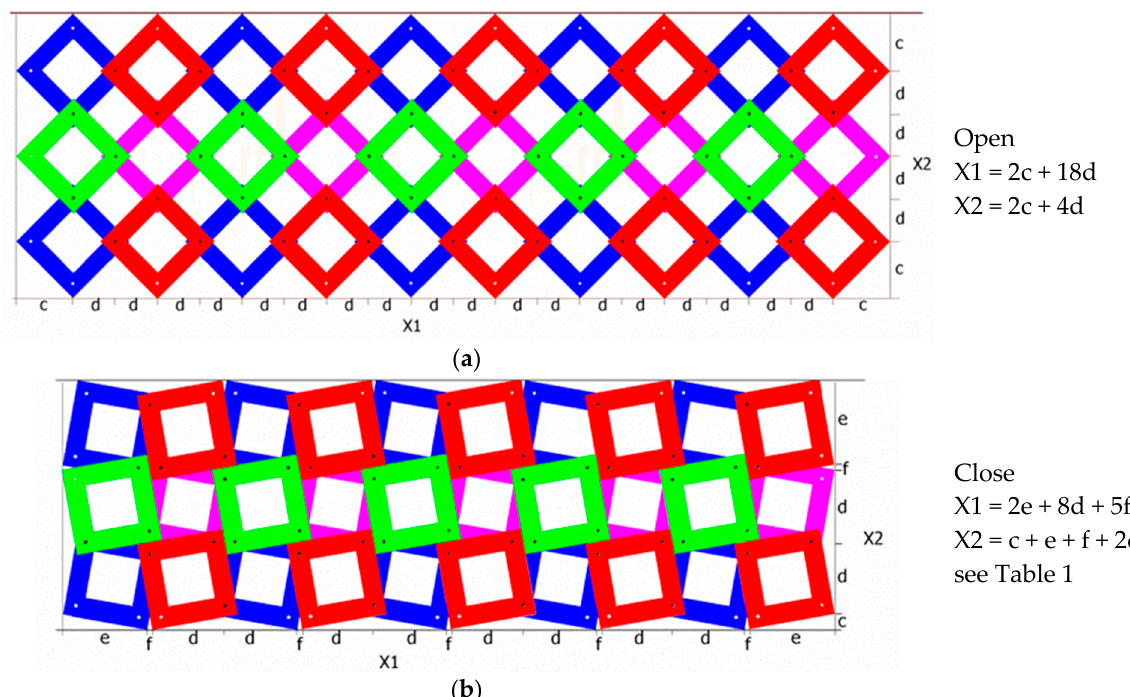
Figure 5. A 3 × 10 planar auxetic structure of rigid square frames in open ( a ) and closed ( b ) positions, along with the method of calculating its linear size.